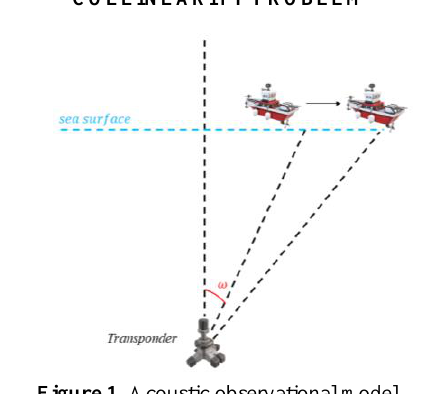
Figure 1 . Acoustic observational